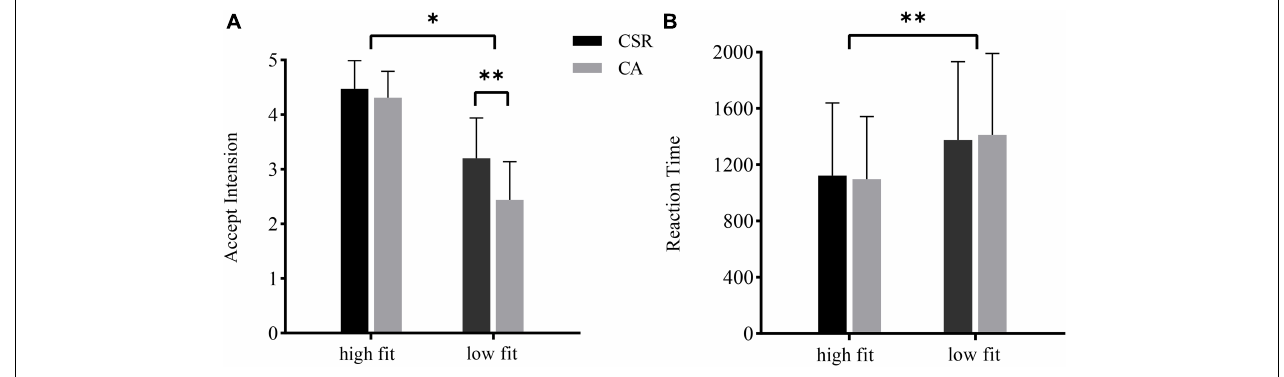
FIGURE 2 | Behavioral results of the accept intention (A) and reaction time (B) for the four conditions of brand extension evaluation. ∗ p < 0.05; ∗∗ p < 0.01.